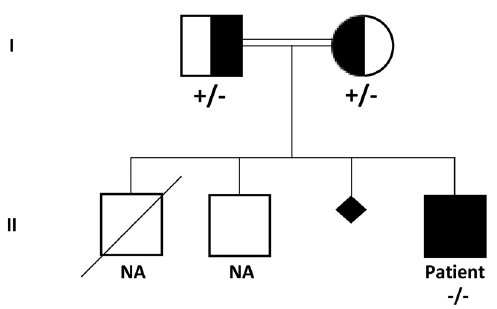
Figure 1. Pedigree chart of the family. Squares and circles indicate men and women, respectively. A diagonal line through a symbol indicates a deceased individual. A small rhombus indicates a miscarriage. Affected individuals are indicated by filled symbols. Carrier individuals are indicated by filled-empty symbols. II-4 genetic analysis revealed a homozygous microdeletion involving the 3p25.1 chromosome region that contains part of the collagenic tail of endplate acetylcholinesterase (COLQ) gene. The microdeletion resulted in heterozygous status in I-1 and I-2. At 55 days of life (DOL), he was brought to the emergency department (ED) of a local hospital for dyspnea and cyanosis. He was intubated and ventilated and developed tonic-clonic fits during hospitalization that were treated successfully with phenobarbitone. He was then discharged after 15 days but was then admitted to our department at DOL84 because of hypotonia, weight loss, and difficult feeding. Weight, length, and head circumference were all <3° centile for his age. Marked hypotonia, dystonia, mild palpebral ptosis, and electroclinic fits (chaotic movements, hyperextension of arms and legs followed by marked hypotonia, apnea and cyanosis) with partial response to